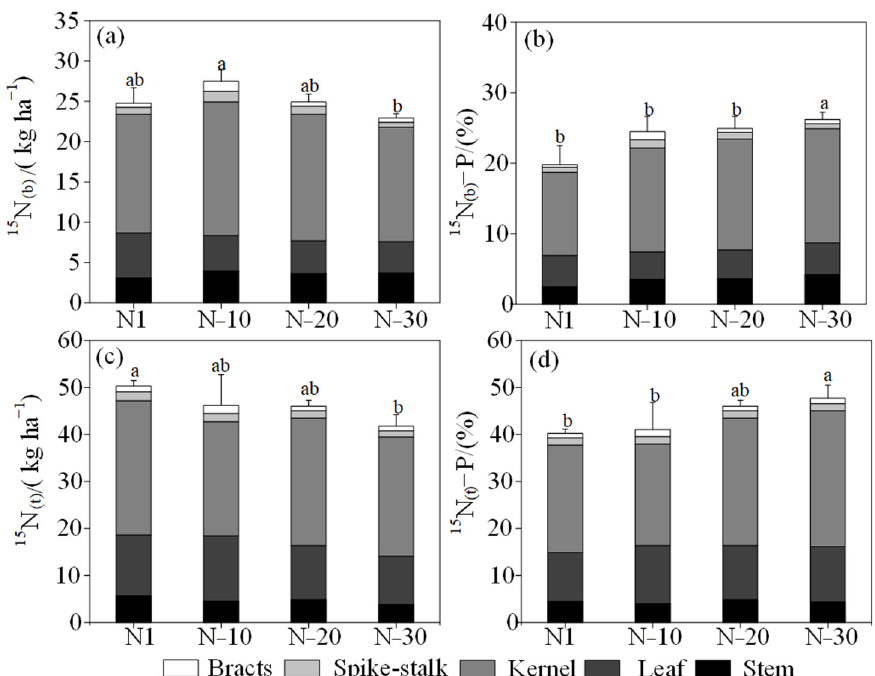
Figure 3. Accumulation and recovery rate of basal fertilizer ( a , b ) and topdressing ( c , d ) in different maize organs. Note: different letters in the same column indicate that the differences in 15 N (b,t) and 15 N (b, t) ‐ P in the whole maize plant reached a significant level ( p < 0.05). N0, N1, N ‐ 10, N ‐ 20 and N ‐ 30 represent the five fertilization treatments.